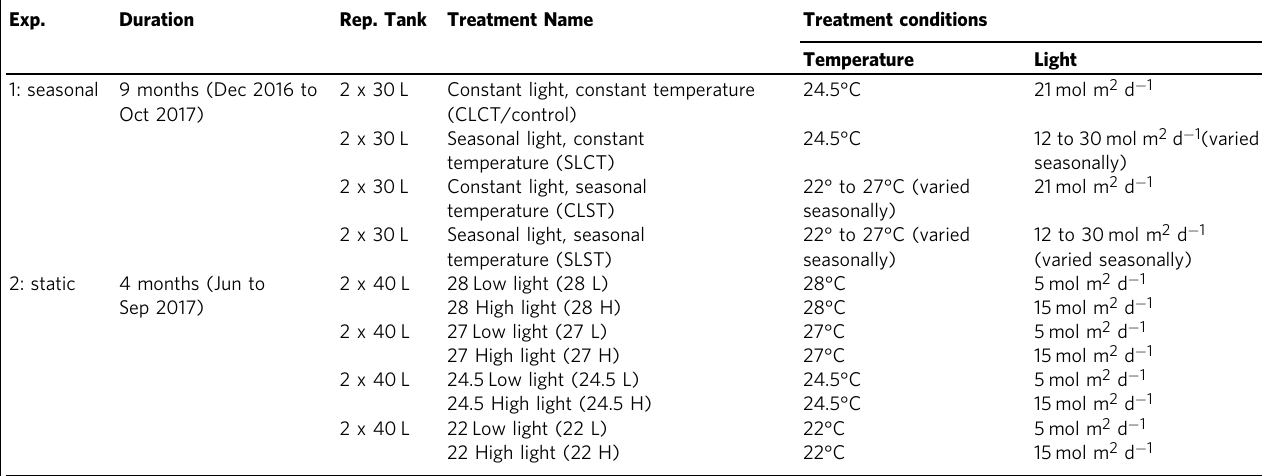
Table 1 Temperature and light treatments. Exp.